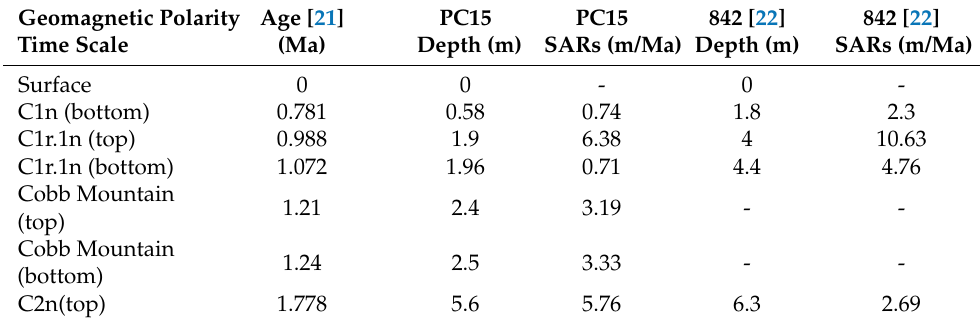
Figure 4. Magnetostratigraphy of the studied core and their correlations to the geomagnetic polarity time scale (GPTS). ( a ) Image of Core PC15; ( b ) ChRM inclination; ( c ) recognized magnetozones (n1–n5 and r1–r4) of core PC15; ( d ) sedimentation rates of ODP 842B site (dash line); ( e ) magnetostratigraphic results of core ODP 136-site 842B [13]; ( f ) sedimentation rates of core PC15 (solid line). See data in Table 1. Table 1. Correlation of magnetozones of core PC15 to the Geomagnetic Polarity Time Scale.